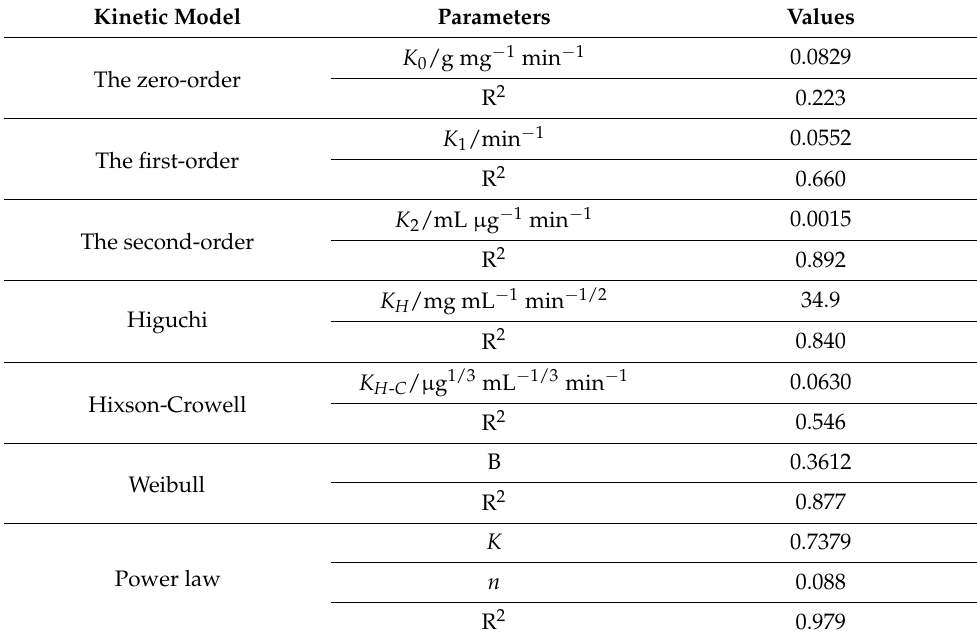
Table 2. List of parameters obtained from the kinetic models release of doxorubicin from m